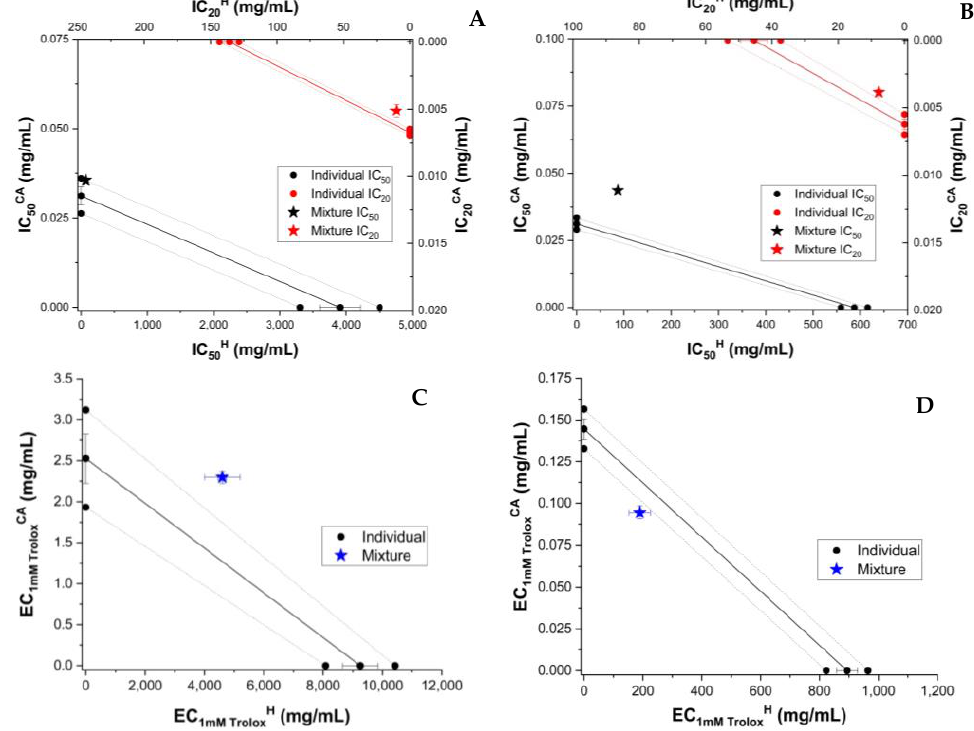
Figure 2. Isobolograms of honey (H) and caffeic acid (CA) based on IC 50 (half-maximal inhibitory concentration) and IC 20 (inhibitory concentration at 20% substrate inhibition) for DPPH ( A ) and ABTS ( B ) methods, and based on EC 1mM Trolox (effective concentration at 1 mM Trolox equivalent of the samples) for CUPRAC ( C ) and FRAP ( D ) methods. The error bars from three measurements are shown for each value. Confidence intervals at 95% confidence are shown by dashed lines.